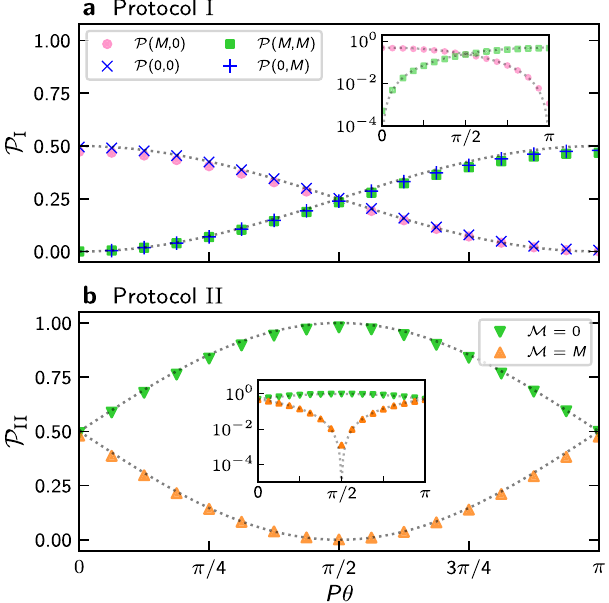
Fig. 2 Readout probabilities for Protocols I and II. Comparison between analytic and numerically calculated probabilities for parameters of Set 1 for different values of P θ . a Results for Protocol I. The pink dot and the blue “ x ” (green square and the blue “ + ” ) depict the probabilities of measuring r = 0 ( r = M ) during the readout, having measured r = M or r = 0 in step (iii), respectively. b Results for Protocol II. The probabilities of measuring N 3 = 0 ( N 3 = M ) in the readout are shown as green (orange) triangles. The dotted line depicts the analytic predictions of the probabilities with respect to P θ . The insets show the accordance between predicted and calculated probabilities in semilogarithmic